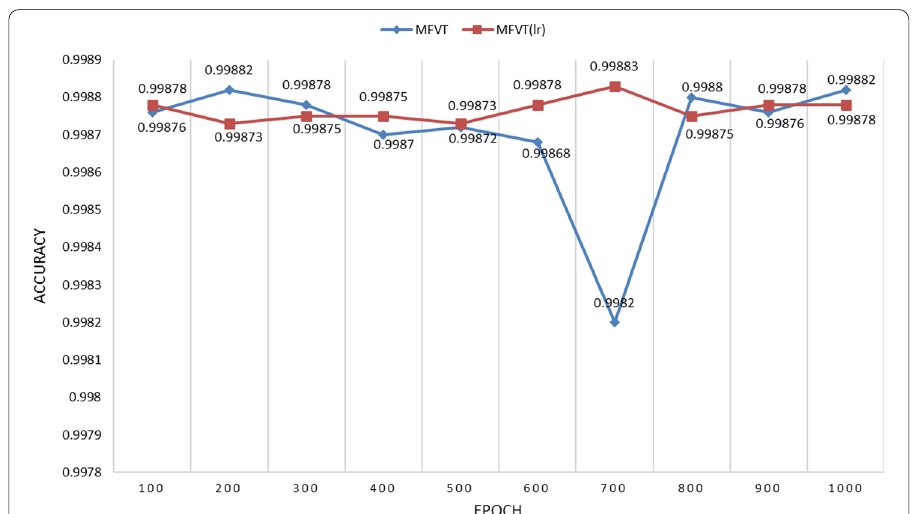
Fig. 11 Experimental results. Blue represents MFVT, red represents accuracy MFVT change